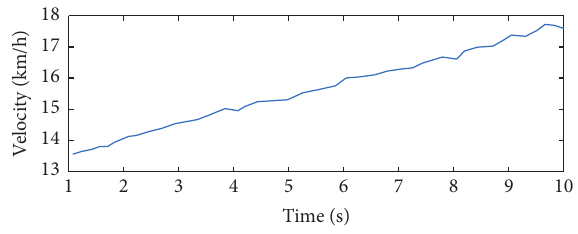
Figure 4: Input velocity in the field test.